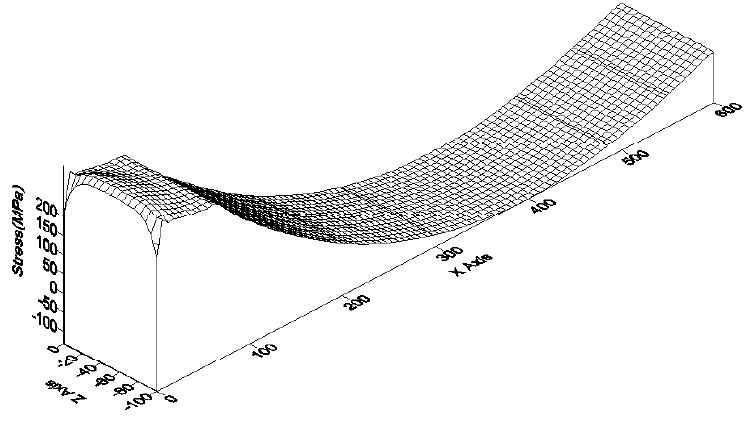
σ distribution on the top surface of the microcantilever Figure 5. Bending stress x